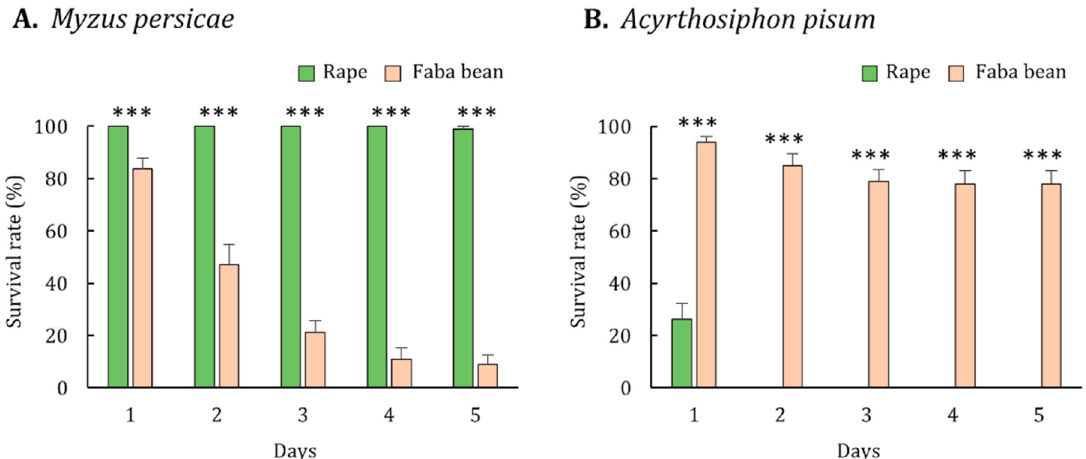
Figure 1. Survival rate of ( A ) Myzus persicae and ( B ) Acyrthosiphon pisum reared on rape and faba bean. Error bars represent the standard errors of the means. Triple asterisks indicate significant differences in survival between aphids reared on rape and faba bean (Mann-Whitney U test, p < 0.001). Table 3. Body weight of newly developed M. persicae and A. pisum adults reared on rape versus on Table 2. Developmental time from first ‐ instar nymph to adult of M. persicae and A. pisum reared on rape versus on faba bean. faba bean.